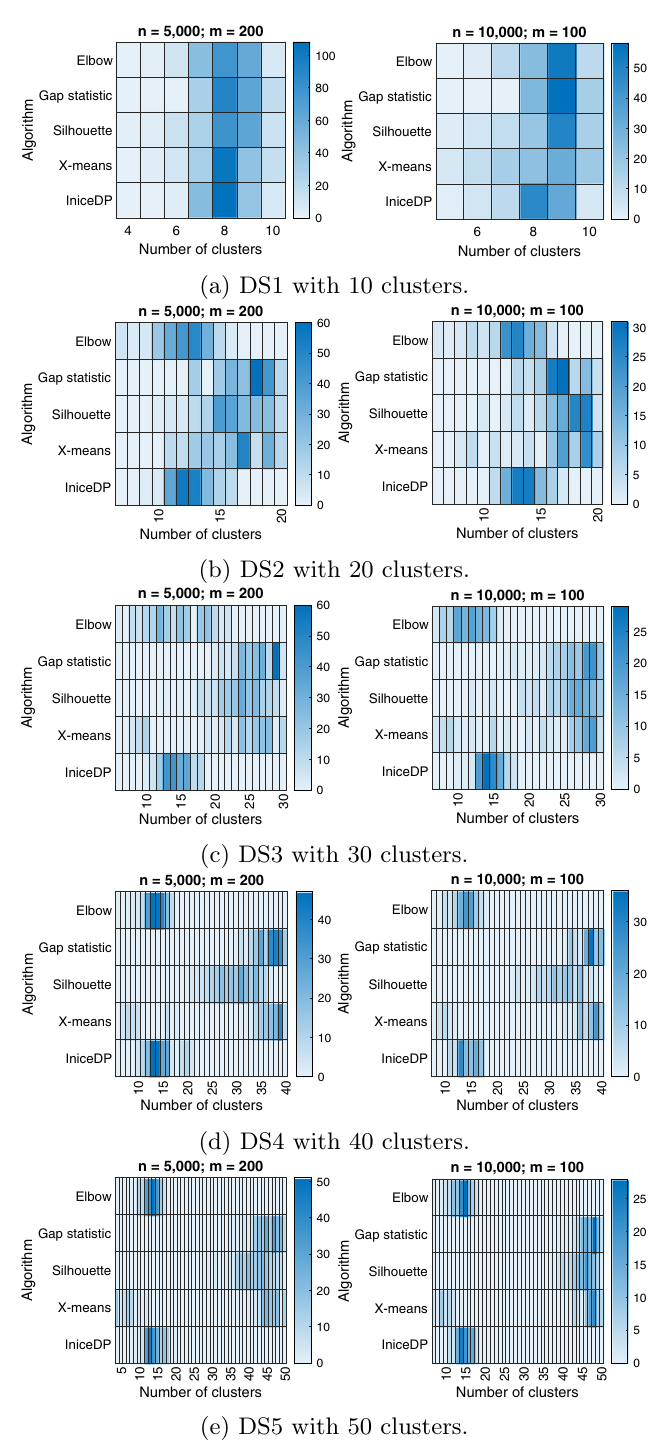
Fig. 3 Heatmaps of the results of the five methods on m random samples in the five synthetic datasets with two RSP representations n : 5000 and 10,000. The columns of each figure are the numbers of clusters, and the rows are the five methods. The dark color in a cell indicates that a high percentage of the m results were identified as the number of clusters by the column with the corresponding